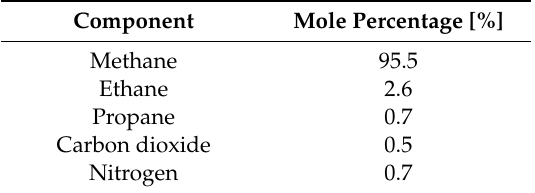
Table 3. Natural gas composition as provided by the natural gas distributor [34].